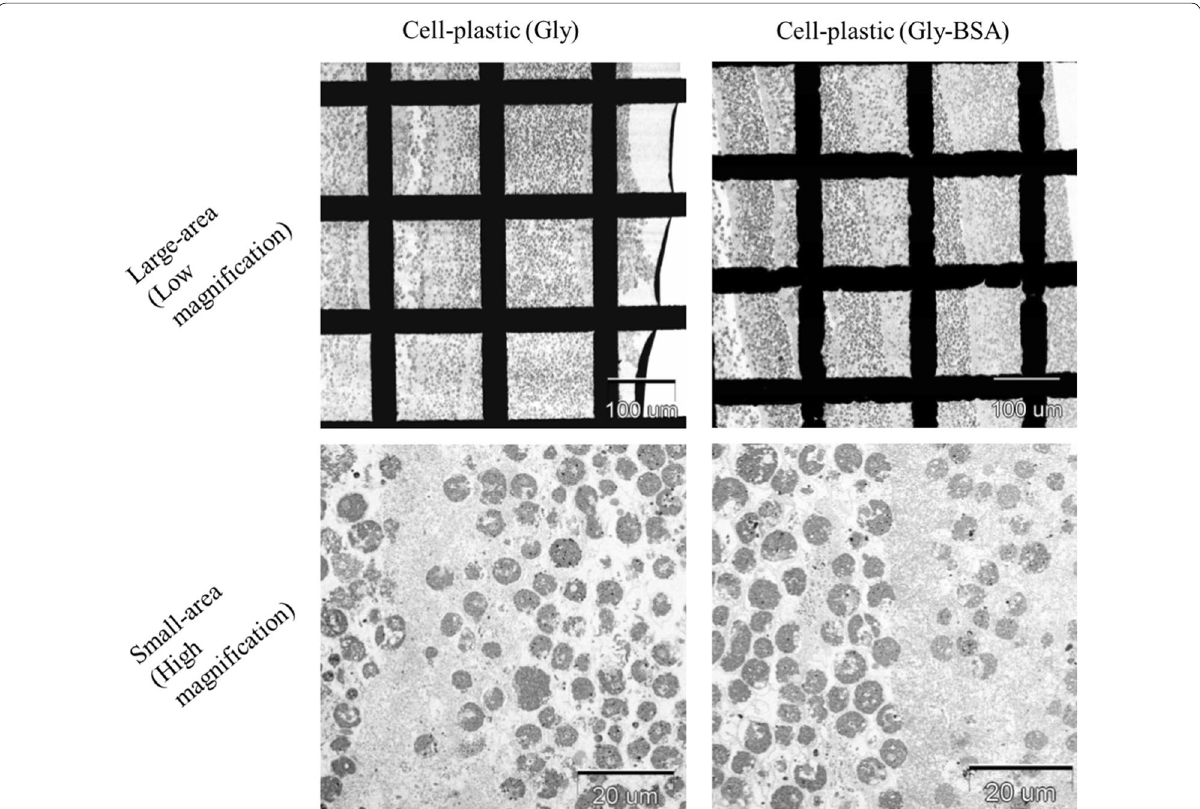
1,000. Figure S2 . Synthesis ×